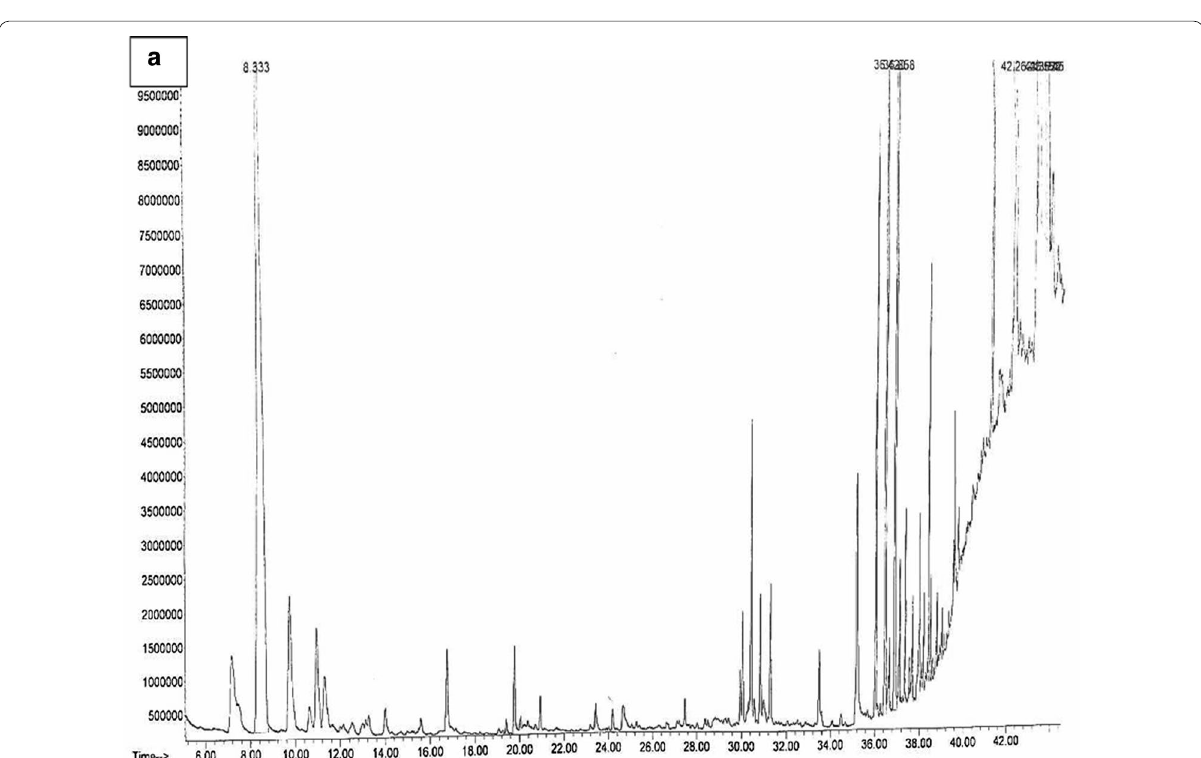
Fig. 1 GCMS analysis of Tetracarpidium conophorum seed extract. a showed spectral analysis of the methanol extract of T. conophorum seed while b showed structures of the identified heterocyclic compounds in the